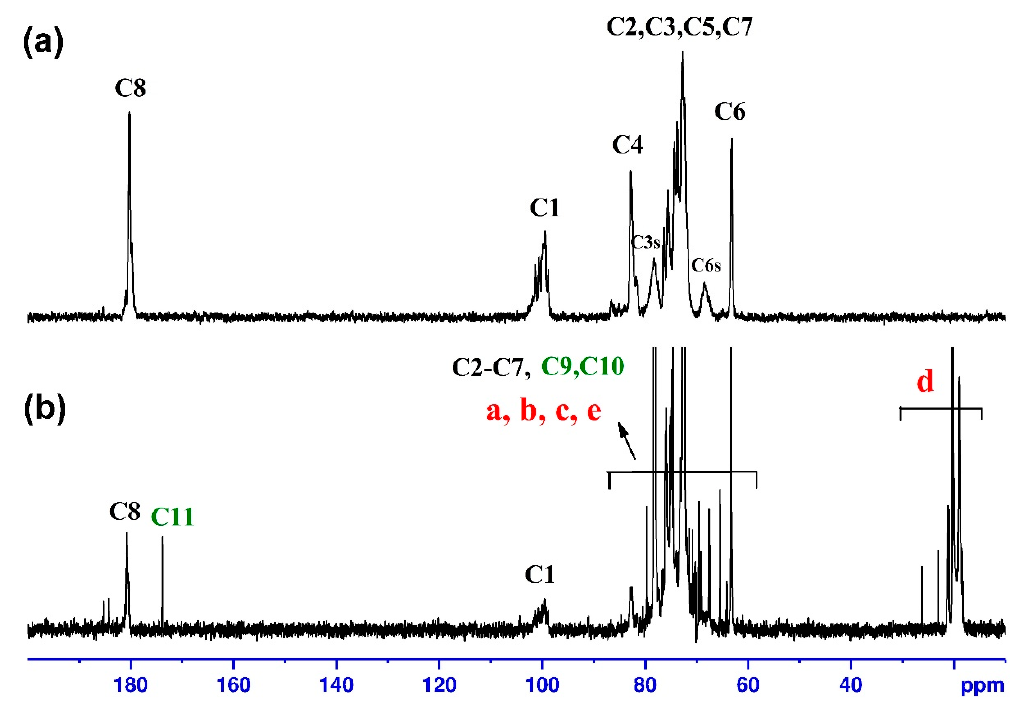
Figure 2. 13 C NMR spectra of CMP ( a ) and Plx- g -CMP ( b ).